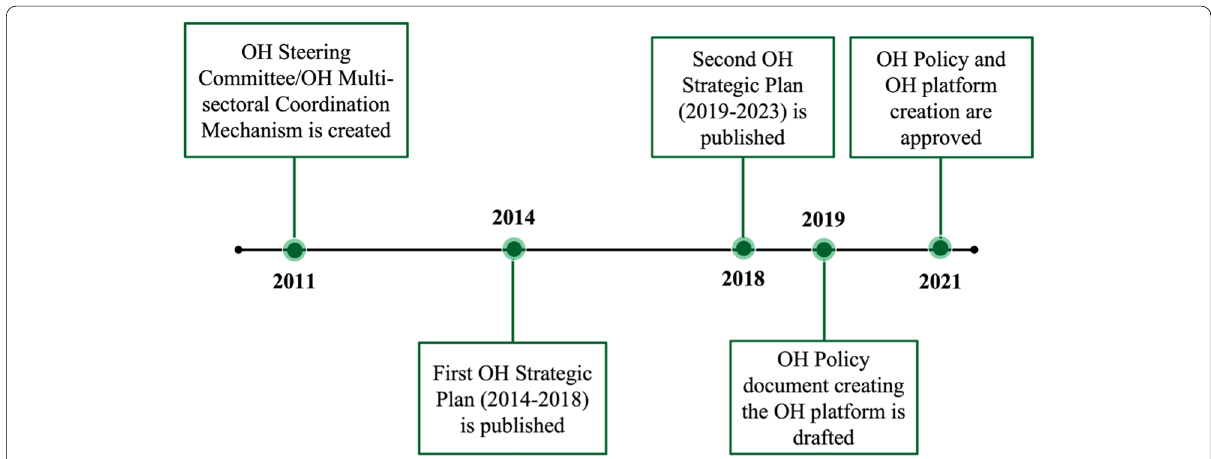
Fig. 2 A timeline of the creation of Rwanda’s OH Governance